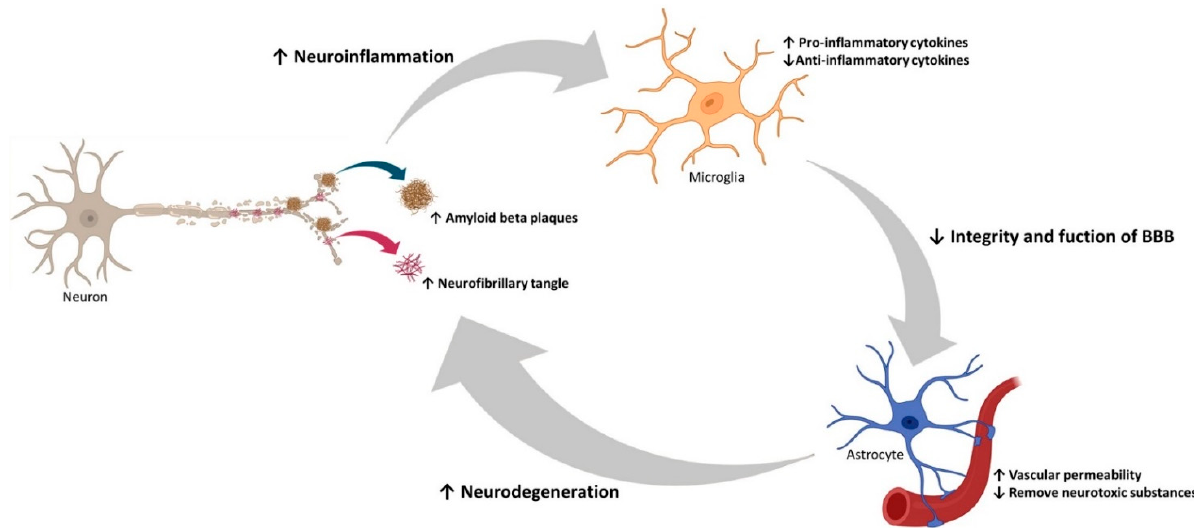
Figure 4. Overview of neuroinflammation, oxidative stress, and autophagy in AD. Representation of the consequences of A β plaque formation, namely, hyperphosphorylation of Tau protein, increased oxidative stress, inflammatory responses by microglia activation, damage to astrocytes, which lead to BBB disruption, causing cerebrovascular damage, dysfunction, and decreased autophagy.